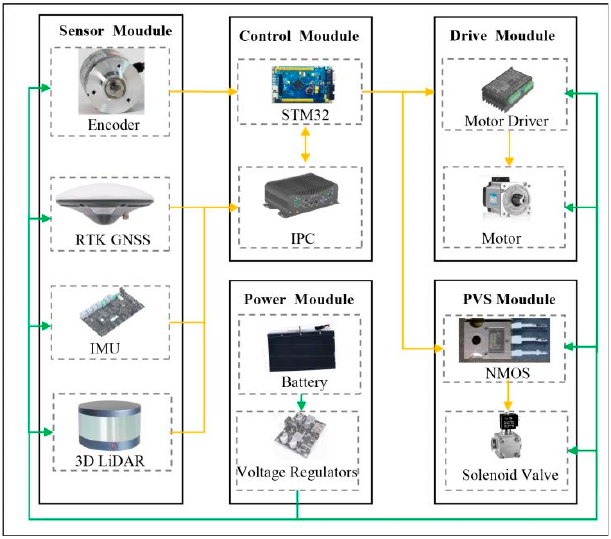
Figure 2. Electronic hardware system design.